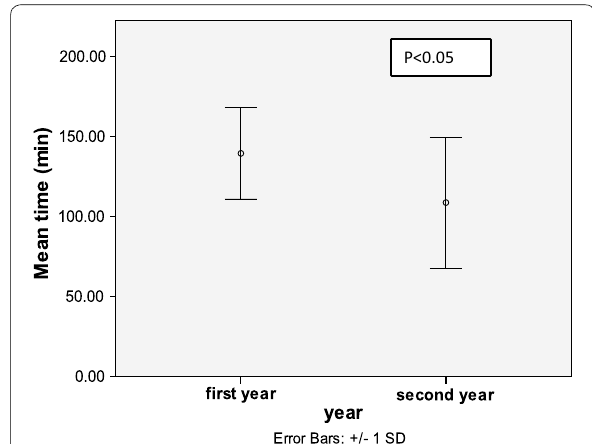
Fig. 2 Comparison between both groups regarding operative time